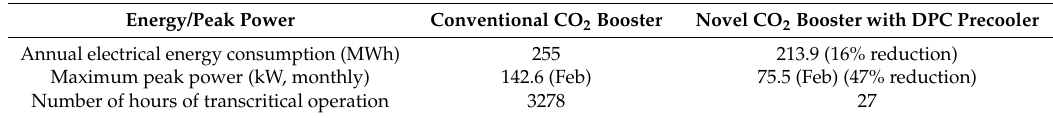
Table 5. Comparison of annual electricity consumption and peak power of the novel and conventional CO 2 booster systems for Adelaide (design MT load: 150 kW—design LT load: 50